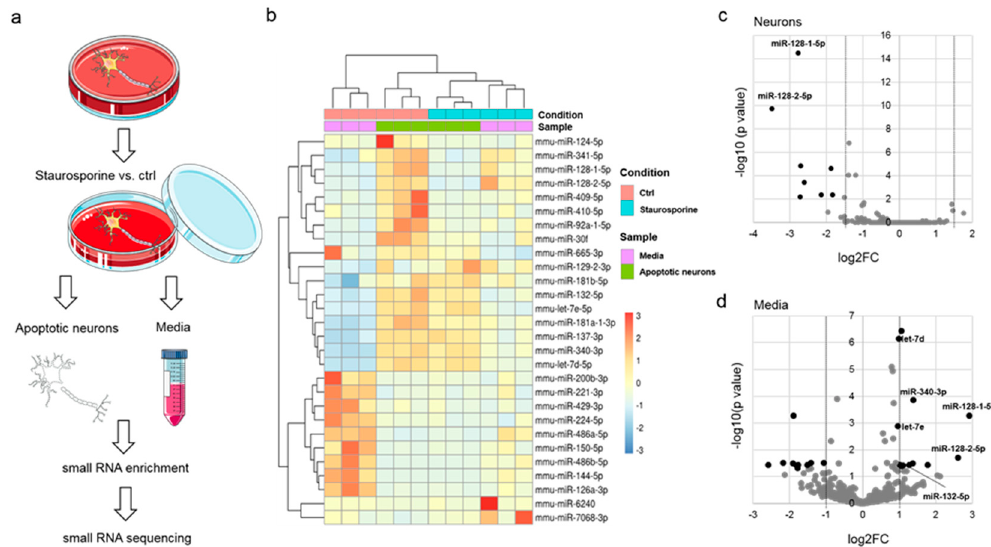
Figure 1. Analysis of miRNA release from injured cortical neurons into the extracellular space by small RNA sequencing. ( a ) Flow chart of apoptosis induction. Murine primary cortical neurons from C57BL/6 mice were incubated with either 1 µM staurosporine or DMSO (solvent control) for 8 h. miRNAs were isolated from the resulting supernatants (media) or apoptotic neurons followed by small RNA enrichment and small RNA sequencing ( n = 3). ( b ) Heat map of significantly dysregulated miRNA species. Color scheme depicts Z-Score for each sample. ( c ) Volcano plot depicting significantly differentially present miRNAs in injured neurons (black dots: fold change FC > ±1.5; p < 0.05). ( d ) Volcano plot depicting significantly differentially present miRNAs in supernatants of apoptotic neurons (media; black dots: FC ≥ ±1.0; p < 0.05).